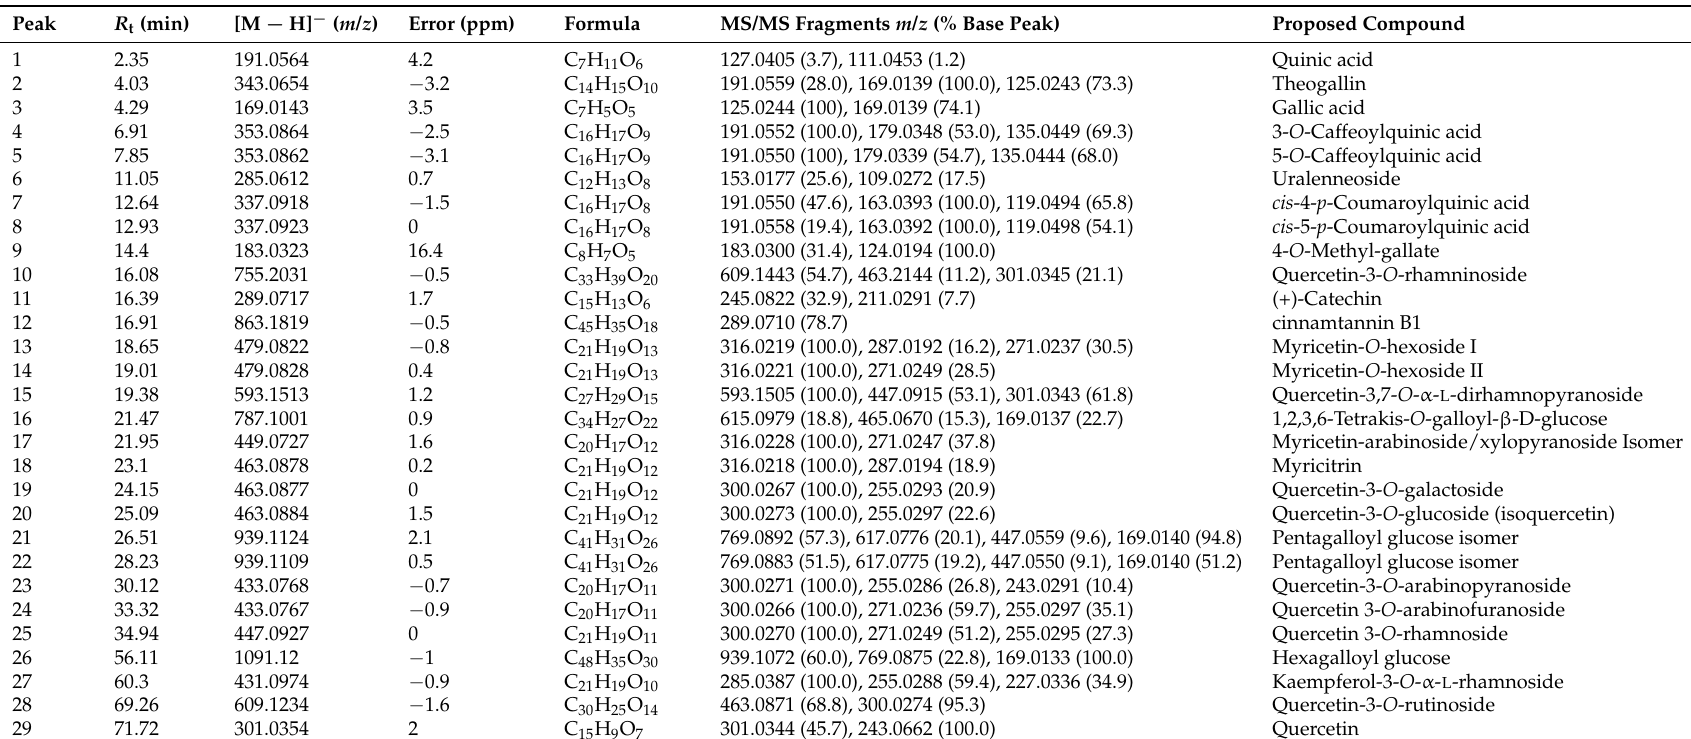
Table 3. Phenolic compounds tentatively identified in ATL by UPLC-QTOF-MS/MS